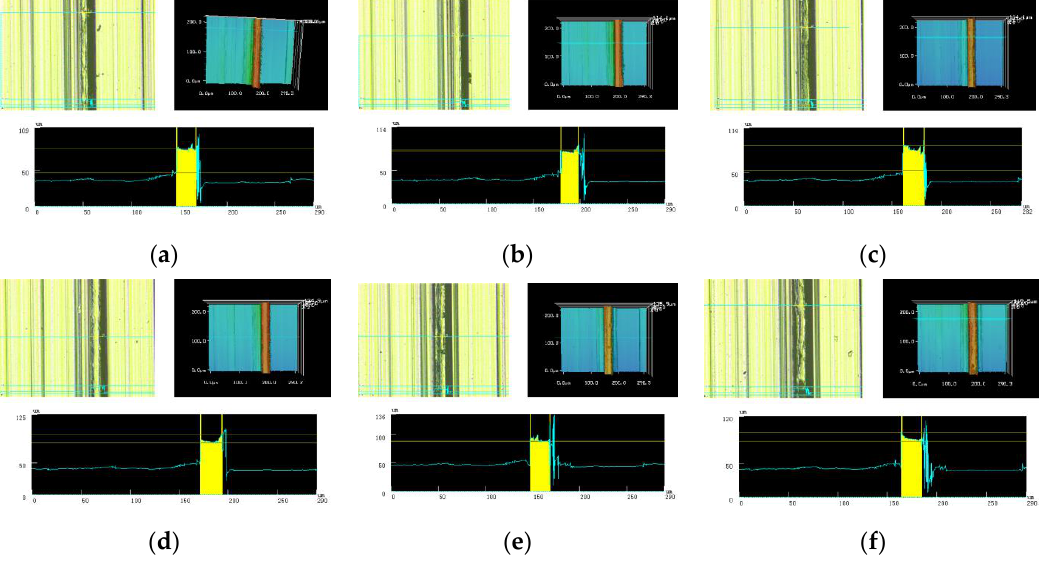
Figure 8. SEM photographs of microtextures at different feeds: ( a ) 2 μm/r , ( b ) 4 μm/r, ( c ) 6 μm/r, ( d ) 8 μm/r, ( e ) 10 μm/r, ( f ) 12 μm/r.